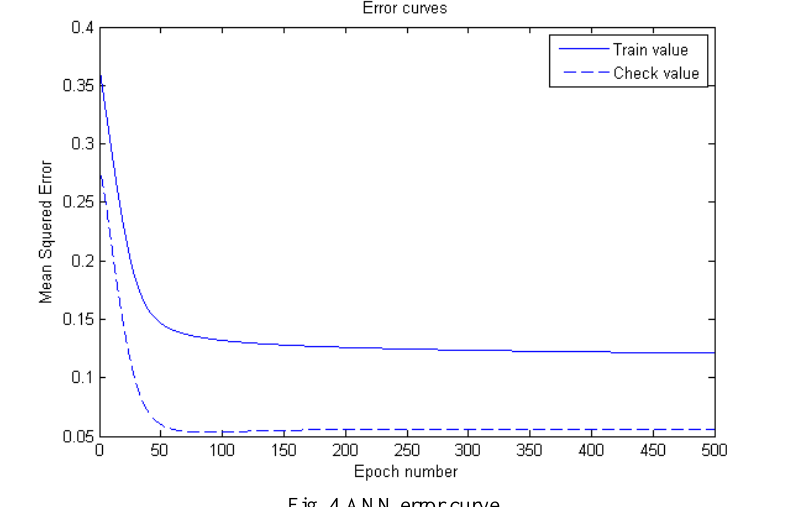
Fig. 4 ANN error curve